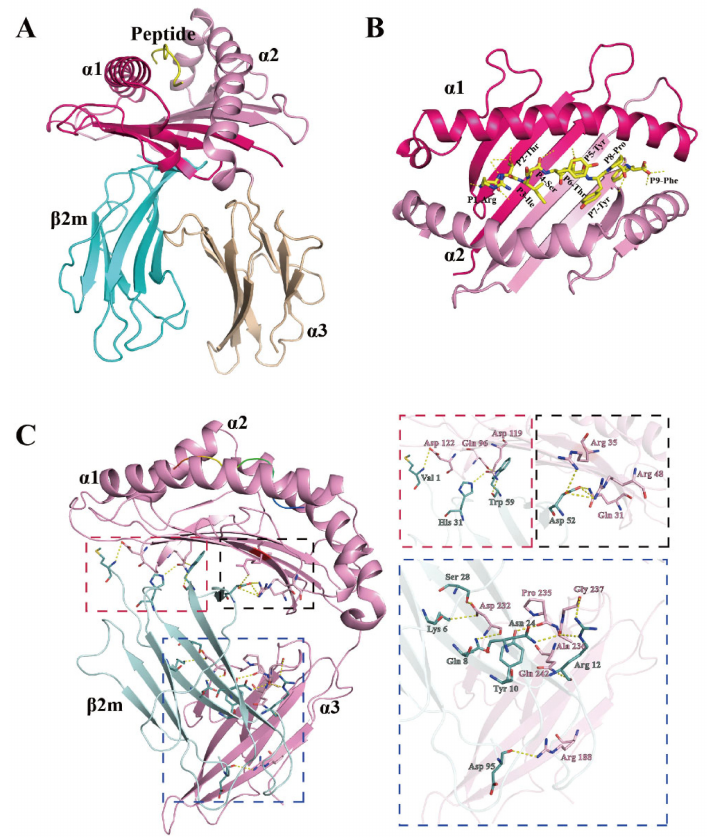
Figure 3. Structure of the dog heterotrimeric pMHC-I complex RTI9/DLA-88*001:04/ β 2m (pDLA- 88*001:04). ( A ) Frontal view of the whole complex in cartoon format. The domains of the H chain are shown in hot pink ( α 1 domain), light pink ( α 2 domain), and beige ( α 3 domain), while β 2m is in cyan and the CDV-derived peptide RTI9 (RTISYTYPF) is in yellow. ( B ) Top view of the α 1 and α 2 domains; the RTI9 peptide is shown in sticks format and its polar interactions with the H chain are indicated with dashed yellow lines. ( C ) Polar interactions between the H chain and β 2m. The H chain is shown in pink and β 2m in teal. Highlighted residues are shown in sticks format with element-coloring (blue, nitrogen; red, oxygen). Polar contacts (hydrogen bonds) are shown as yellow dashed lines. Interdomain interaction sites are boxed with dotted lines, and shown individually and enlarged at the right in boxes of matching